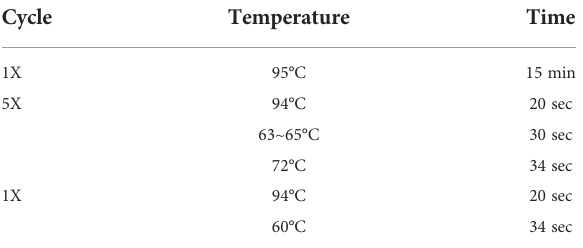
TABLE 2 RT − qPCR procedure.